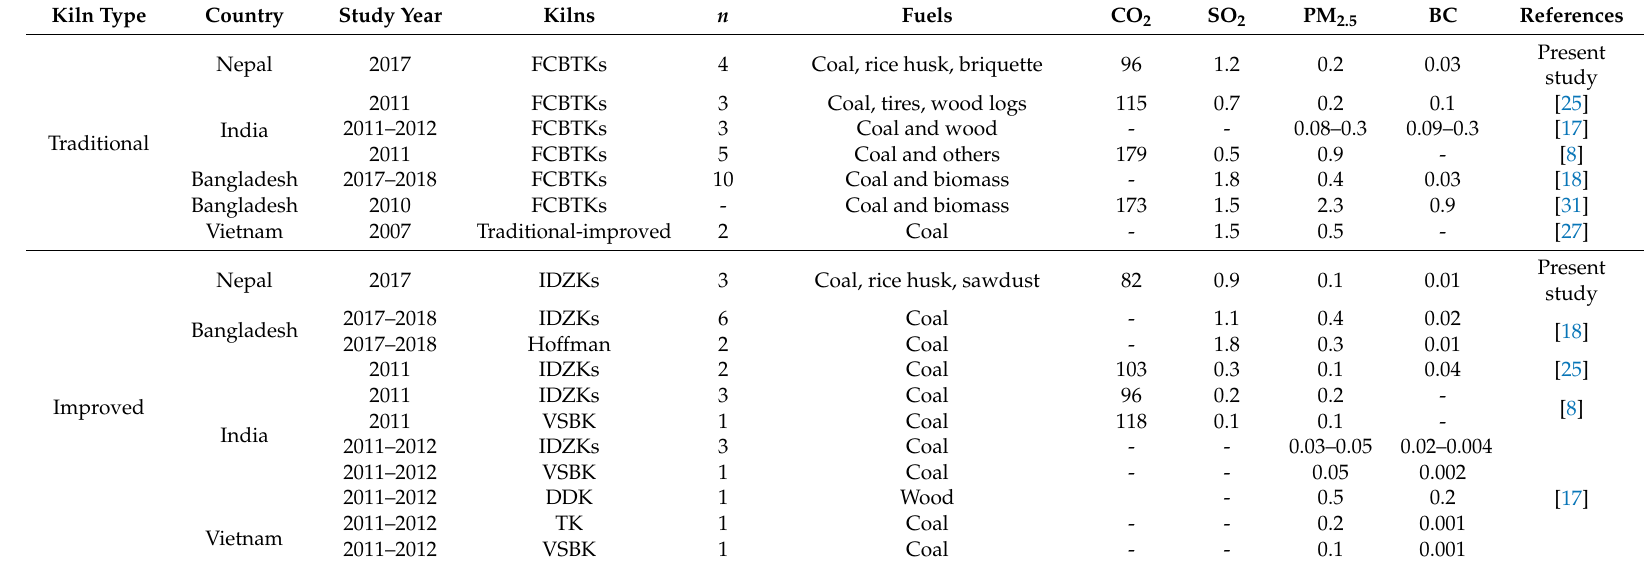
Table 7. Summary of emission factors of different pollutants per kilogram of brick produced (g/kg of fired brick) in this study compared to previous studies. Kiln